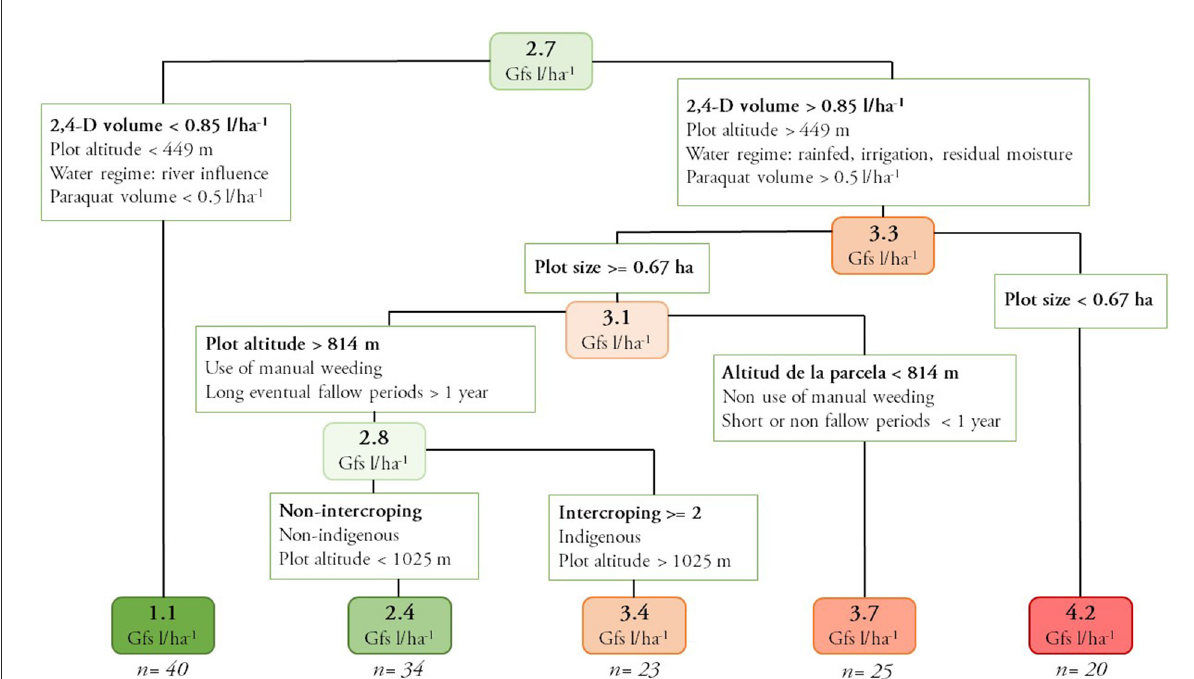
FIGURE4 Regression tree of the joint regions and their 5 terminal nodes or groups. Relative error = 0.71, or fraction of the variance not explained by the regression tree (1–R 2 ). Inside the white boxes, the main variables that define the separation from the groups are shown in bold, and with standard letters the substitute variables, which have a behavior similar to the main variables, although they do not separate the groups. The colored boxes indicate the average values of the response variable (volume of glyphosate in liters/ha − 1 ) and if these are low (green) or high (orange) values.